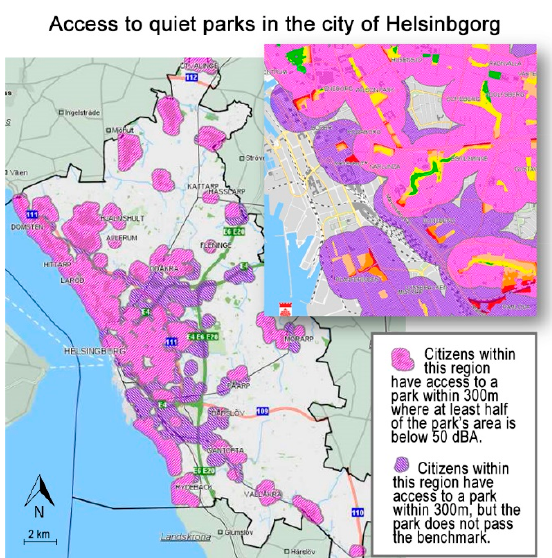
Figure 5. Map showing accessibility of parks and quiet parks in the City of Helsingborg. Adjusted and translated from the City’s action plan against noise